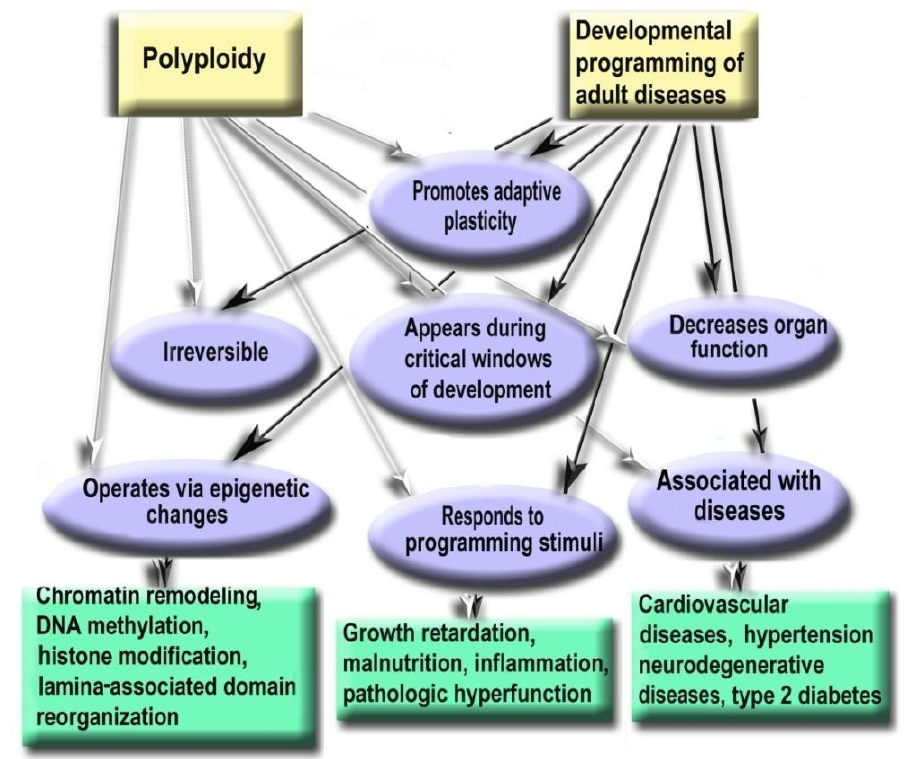
Figure 6. Polyploidy and developmental programming of adult diseases show similar properties.